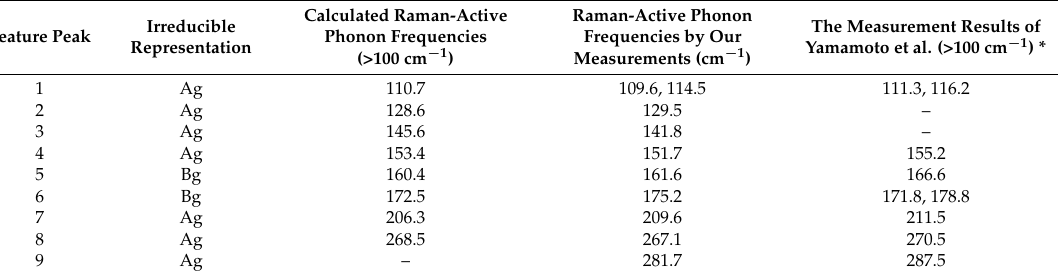
Table 1. Comparison of Raman-active frequencies between our measurements and calculations in the range of 100 cm − 1 –300 cm − 1 .